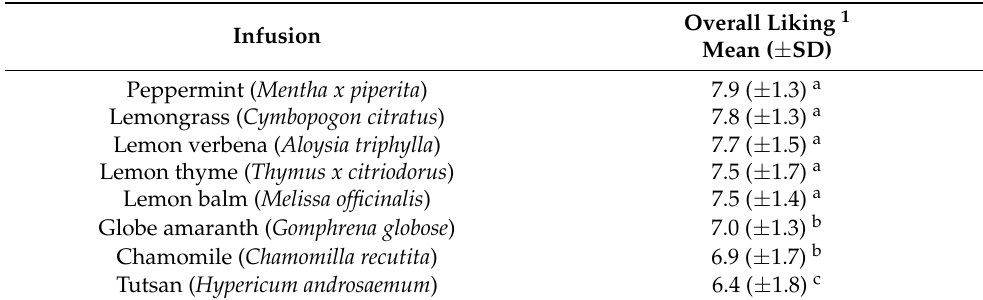
Table 2. Mean overall liking scores for the different herbal infusions under evaluation during the development of the emotional profile